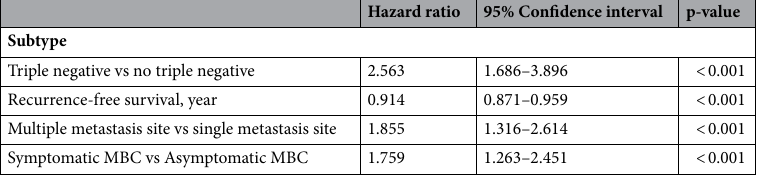
Table 4. Multivariate analysis of post-recurrence survival. MBC metastatic breast